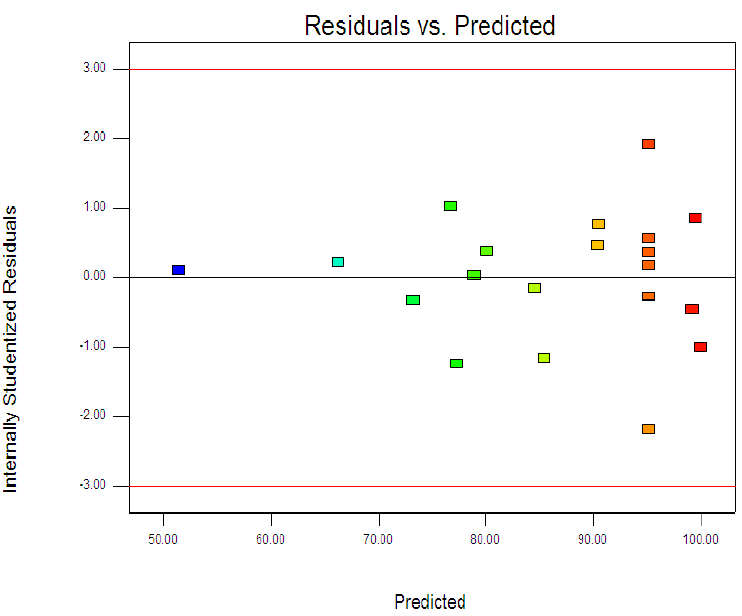
Figure 5. Plot of the residuals against the predicted